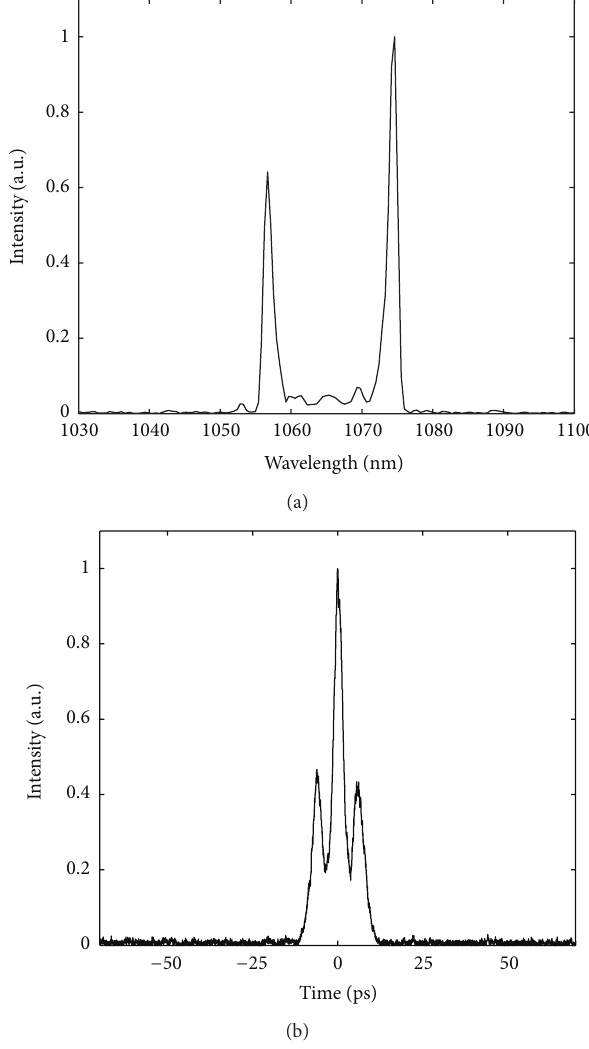
Figure 7: Characteristics of the mode-locked pulses operating in dual-wavelength dual-pulse state. (a) Optical spectrum. (b) Autocorrelation